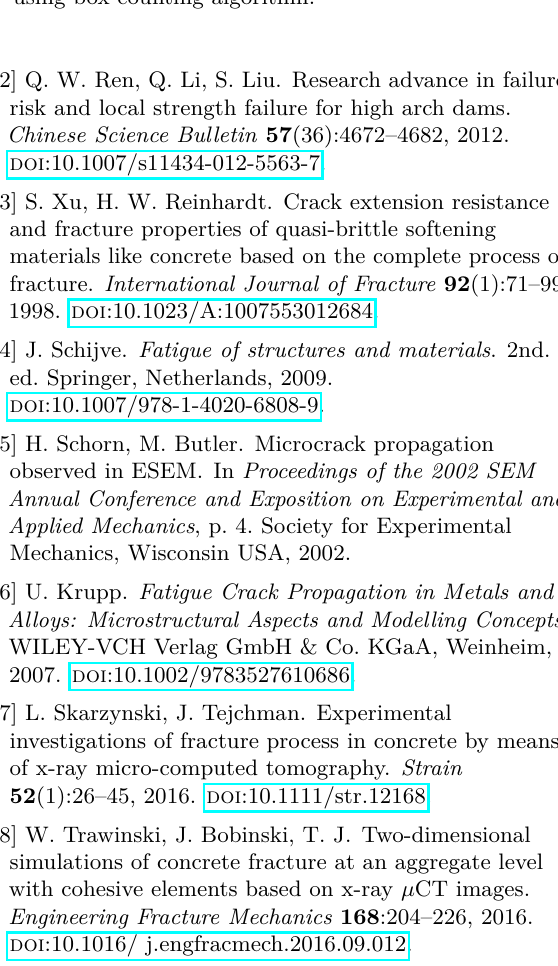
Figure 8. Visualization of the extracted fracture surface with the table and graph of the values obtained using box counting